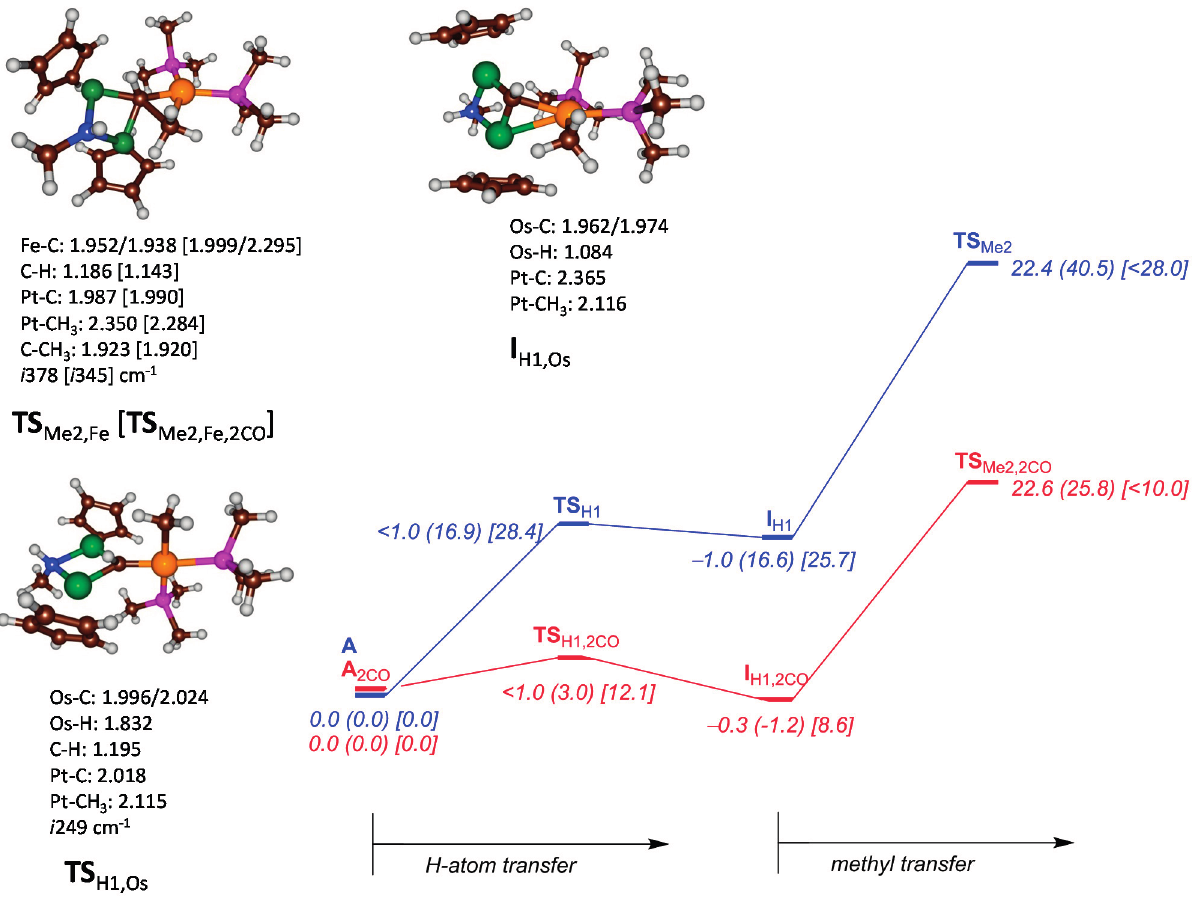
Figure 2. Potential energy landscape for ethylidene formation from complex A with initial hydrogen abstraction followed by methyl transfer. All energies are obtained with UB3LYP/BS2 and contain zero-point and solvent corrections in kcal·mol − 1 . Optimized geometries of key structures are given with bond lengths in angstroms. The blue surface represents the bare system without CO, whereas the red surface contains the CO bound complexes. Energy data is given for Fe (Ru) [Os]